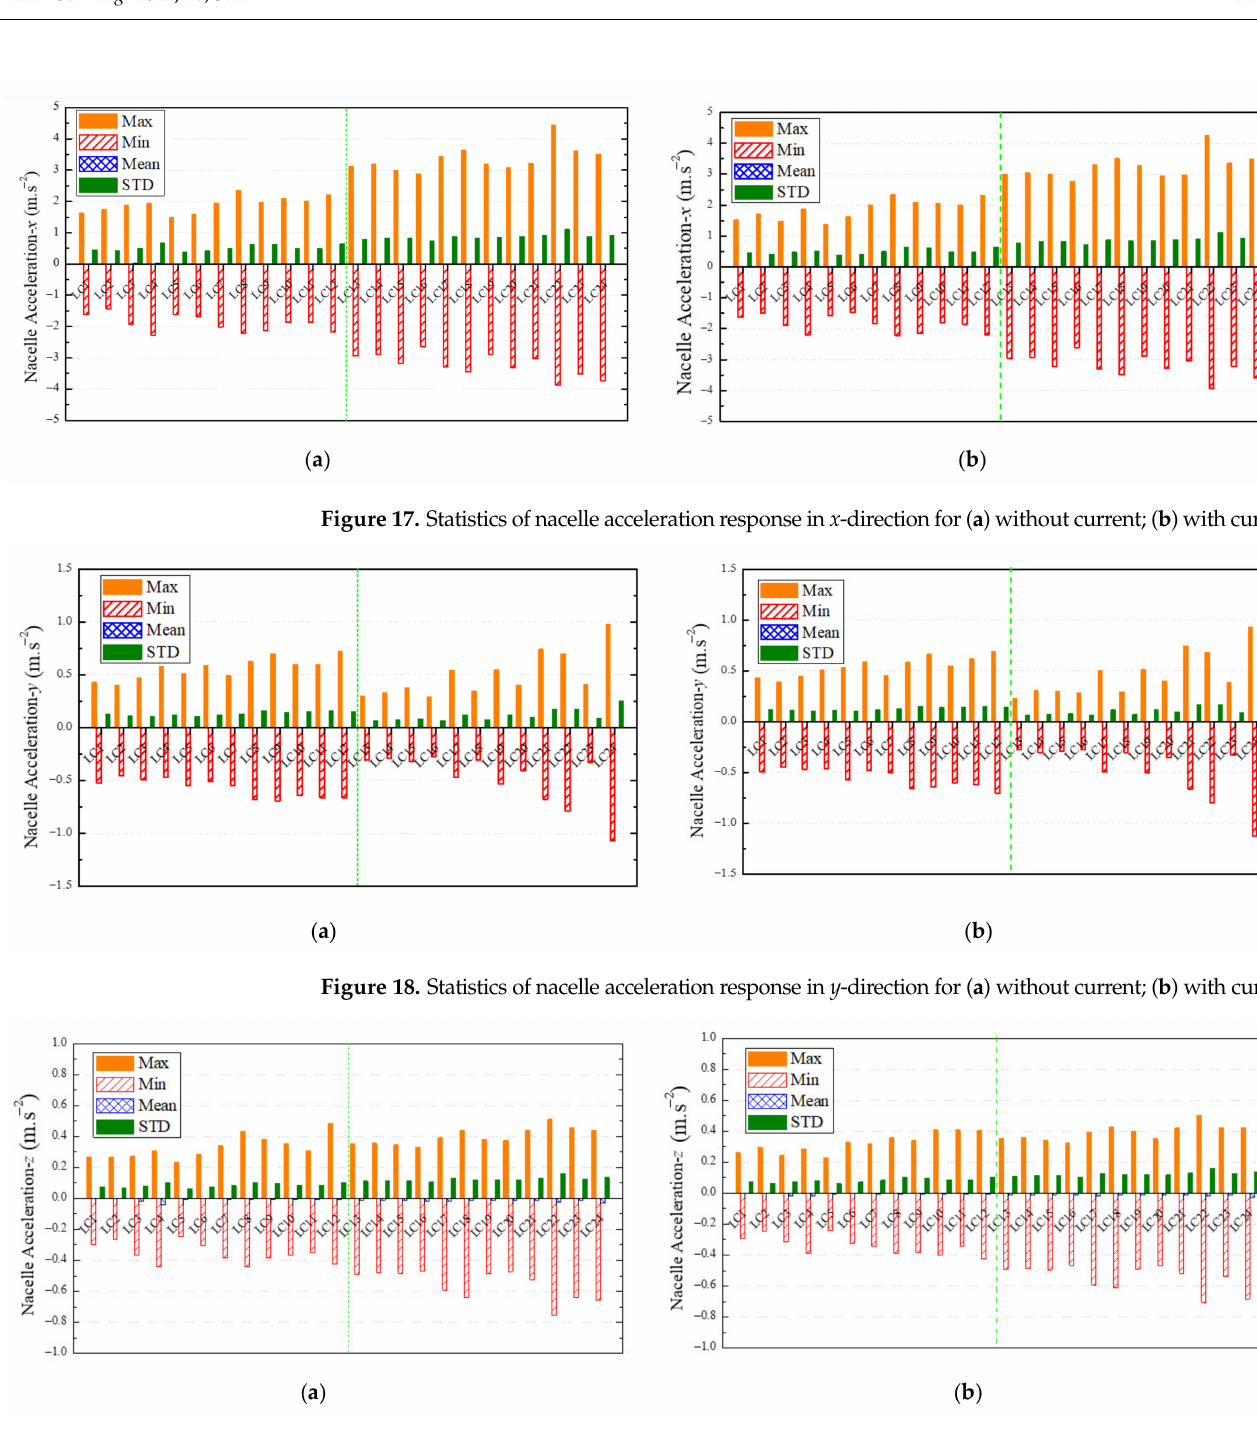
Figure 19. Statistics of nacelle acceleration response in z -direction for ( a ) without current; ( b ) with